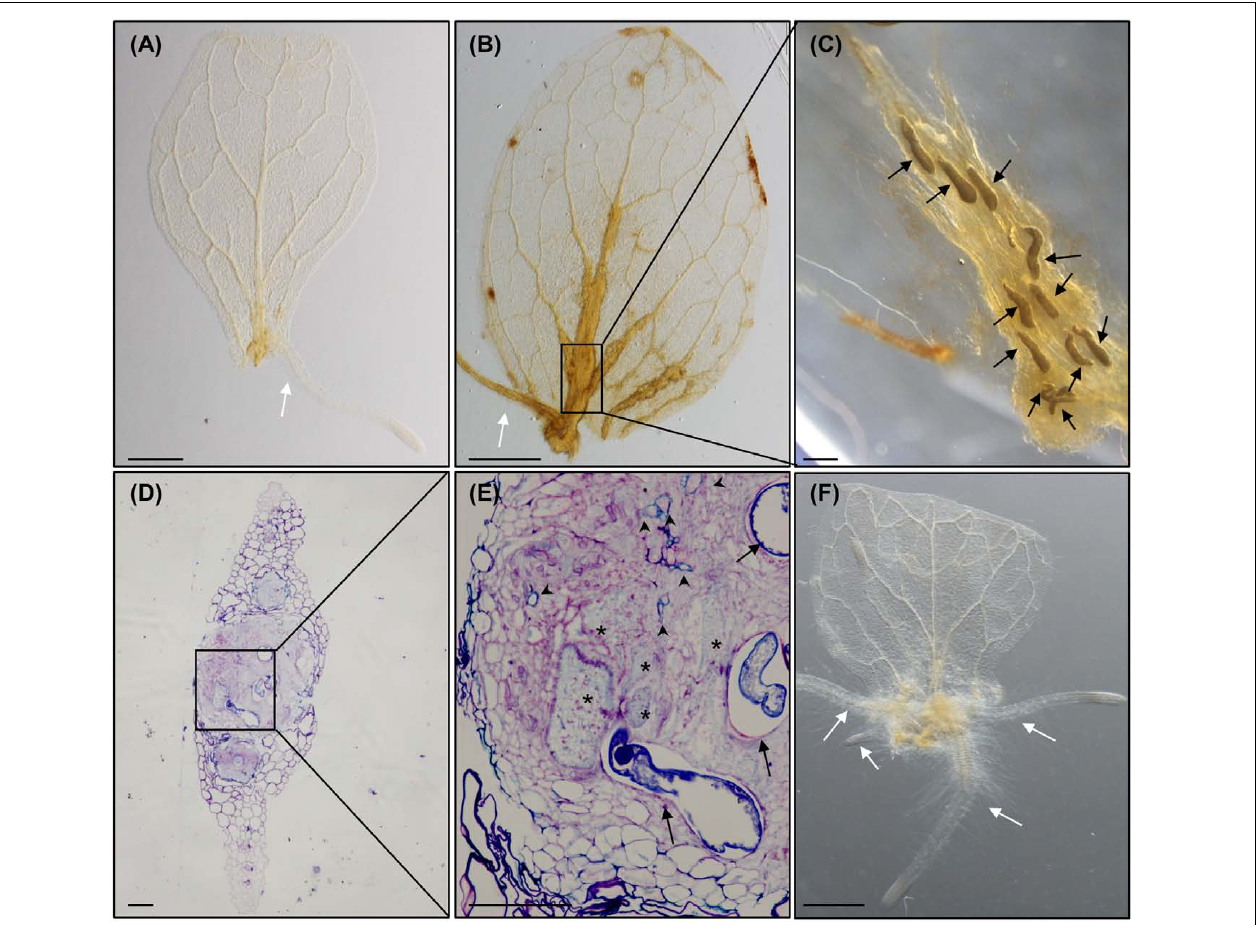
FIGURE 3 | Meloidogyne javanica RKNs form a callus-like structure in Arabidopsis thaliana leaves resembling calli formed with exogenous auxins. (A) Arabidopsis leaves cultured in Gamborg B5 medium supplemented with 3% sucrose, in the absence of any additional phytohormones, at 8 days after culture (dac). (B) Arabidopsis leaves cultured in Gamborg B5 medium supplemented with 3% sucrose, in the absence of any additional phytohormones but inoculated with M. javanica juveniles, at 18 daci, callus-like structures are observed along the veins. (C) Close up view of the nematodes established inside the callus- like structure induced in an infected leaf embedded in araldite at stages J2 to J4, (D,E) semithin sections of these leaves stained with toluidine in the area of the callus-like structures where GCs are clearly observed close to the female. (F) Leaf explant when cultured in Gamborg B5 implemented with 3% sucrose containing 0.1 µ M of exogenous IAA at 8 dac. Black arrows, white arrows and asterisks indicate the nematode, the adventitious roots (ARs) and the GCs, respectively. Abundant xylem vessels around the GCs are also indicated with arrow heads in E . N ≥ 45. Scale Bars: 500 µ m (A,B,F) and 100 µ m (C–E)